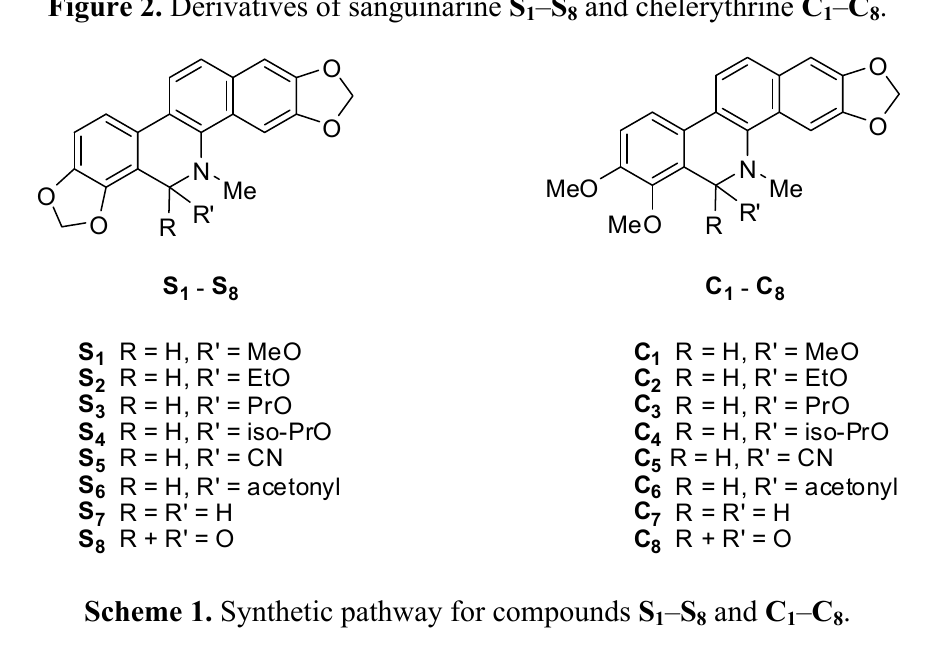
Figure 2. Derivatives of sanguinarine S